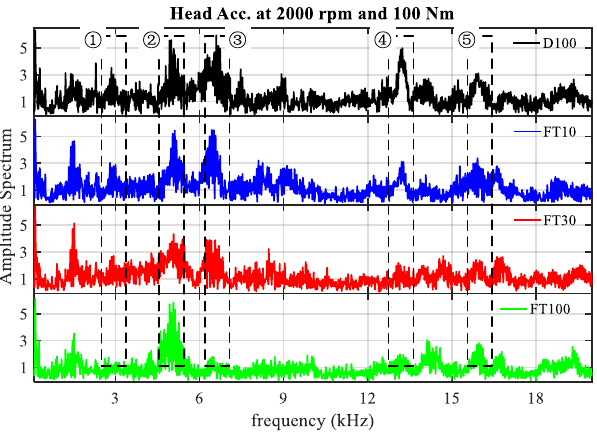
Figure 8. Frequency domain curve of cylinder head vibration acceleration.